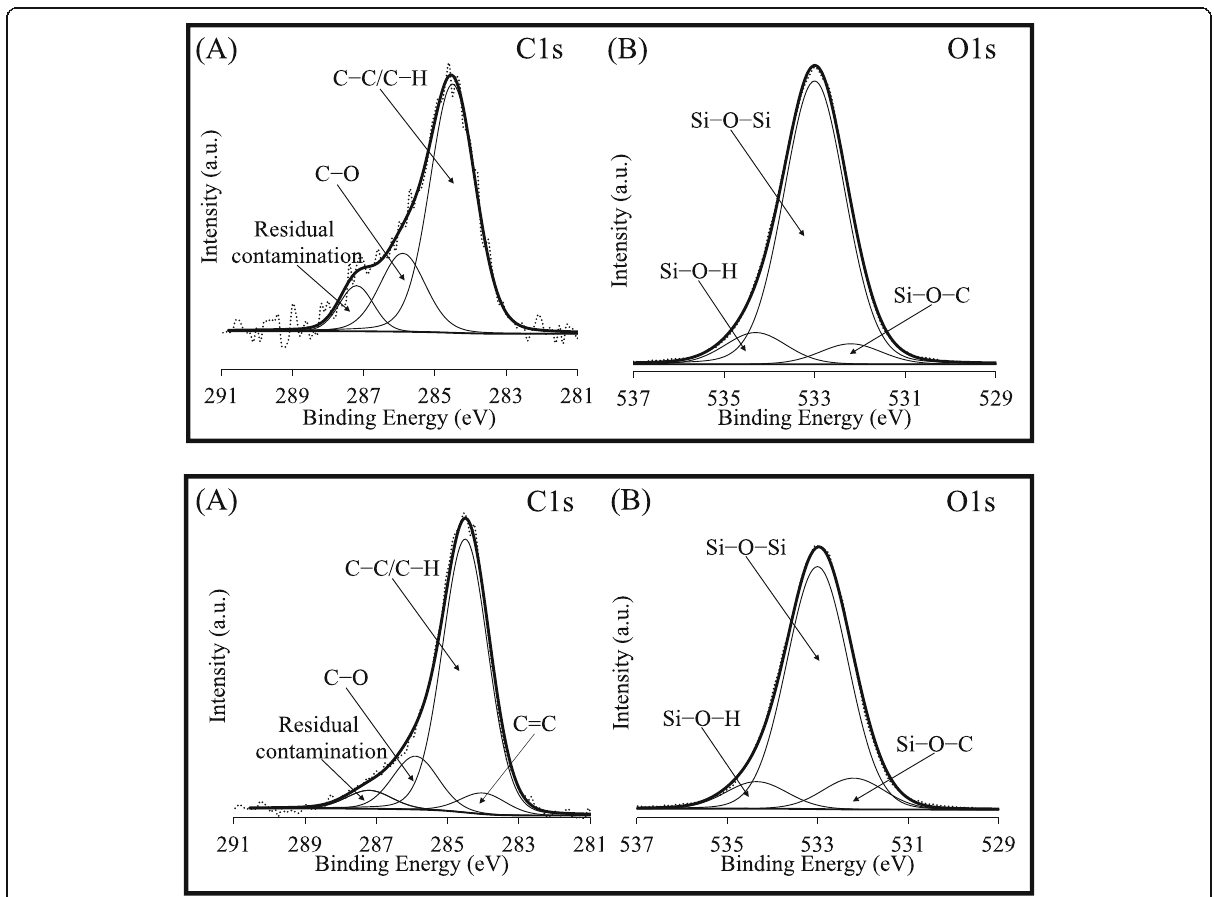
Fig. 8 Representative core level high-resolution C1s and O1s spectra of ( a ) HMS and ( b )